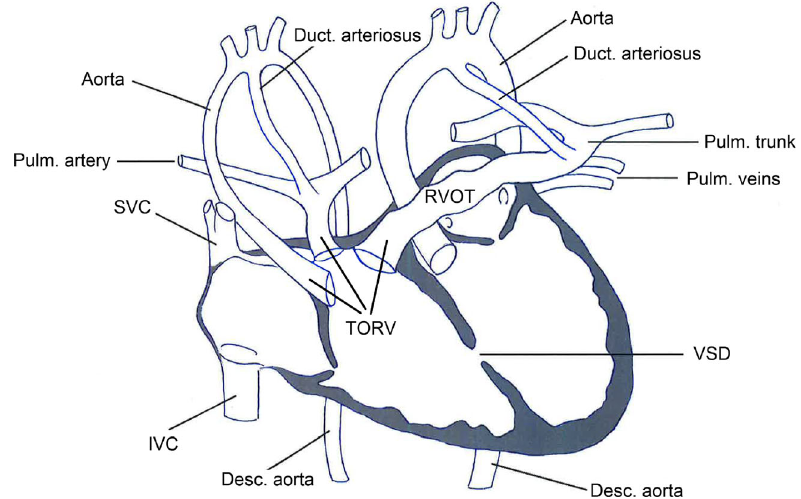
Fig 6 Schematic drawing of the fused heart of case 3. There were two ventricles and two atria. A normally located left aorta arose from the left ventricle. At the right atrium small pulmonary veins were seen. From the right ventricle the second, relative smaller, right aorta, right pulmonary trunk and a right ventricle outflow tract ( RVOT ) of the left pulmonary